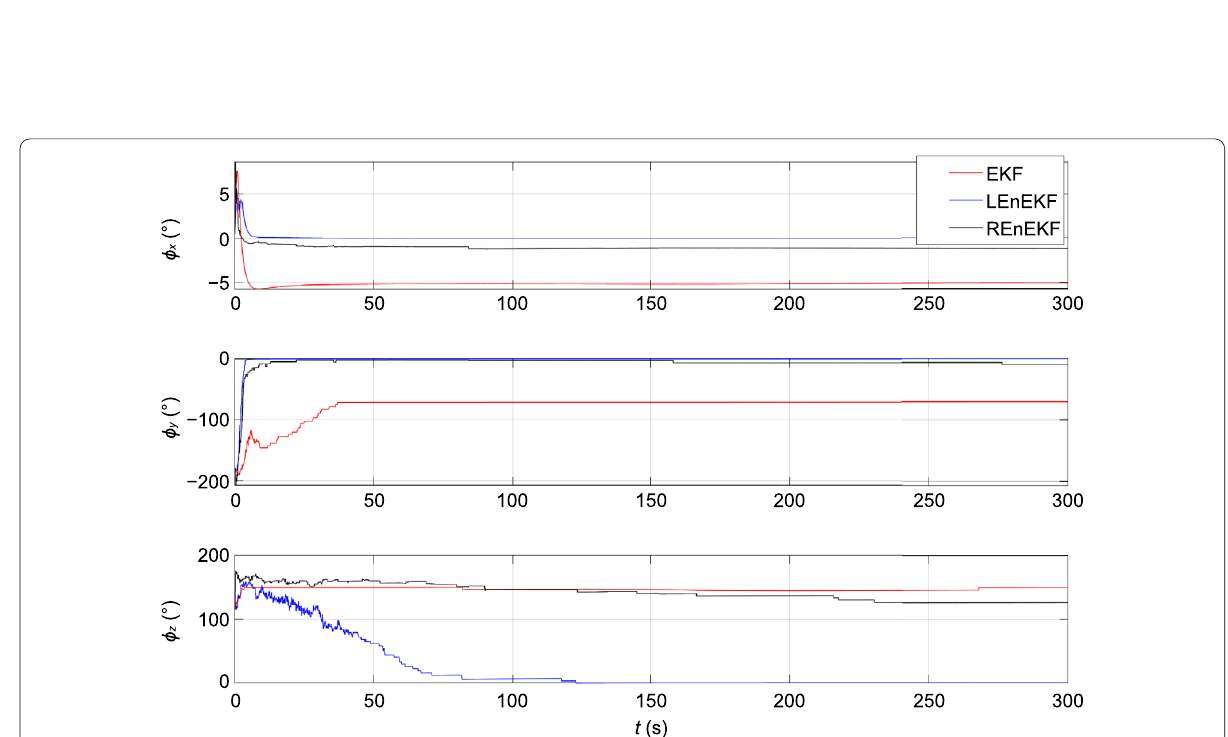
Fig. 2 The mean errors of the three angles in simulation experiment with large misalignment